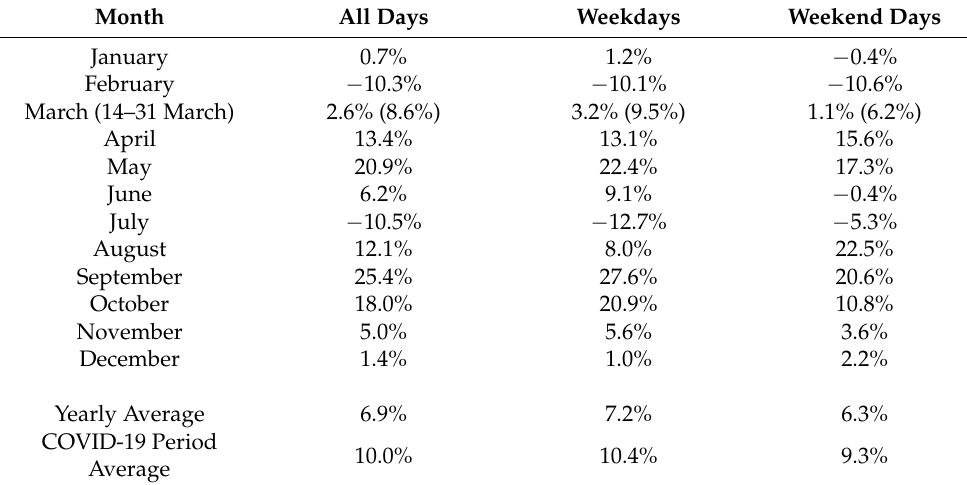
Table 2. Change in energy use for 2020 compared to a comparison baseline for Feeders A-D showing monthly energy use. Values are not normalized for temperature. Positive values indicate higher 2020 energy use compared to the counterfactual model constructed using the 2018–2019 baseline during the comparable monthly period. See Figure S2 for the yearly summary of individual feeders and Figure S3 for a weekly summary chart for individual